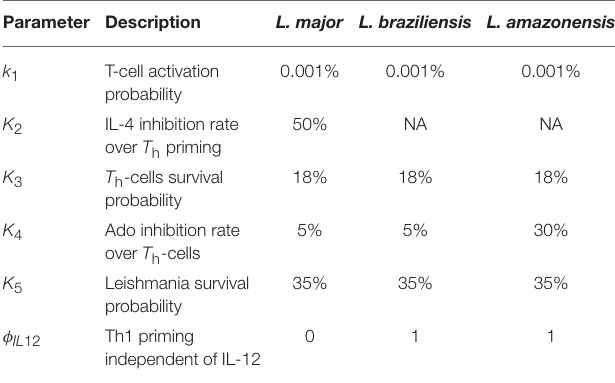
TABLE 3 | Parameters and values used to simulate each of the three models of cutaneous